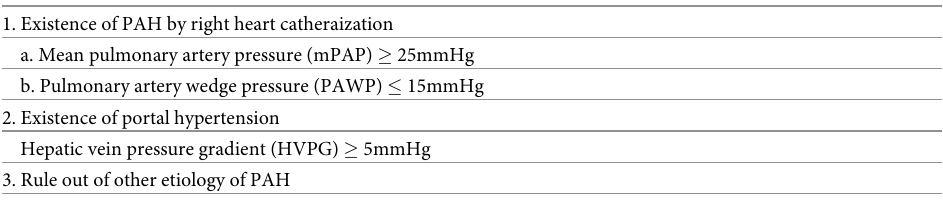
Table 5. Diagnosis criteria of PoPH